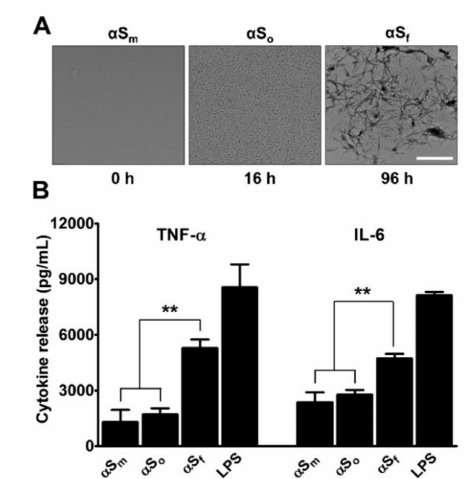
Figure 2. Impact of α -synuclein species on microglial cytokine release. ( A ) Transmission electron microscopy images of α S (70 µ g / ml) samples agitated at 37 ◦ C by orbital shaking and harvested after 16h or 96h. Images show the presence of oligomers ( α S o ) and fibrillary species ( α S f ), at 16 and 96 h, respectively. Scale bar: 1 µ m. ( B ) Impact that samples of α S (70 µ g / mL) harvested after 16 h ( α S o ) or 96 h ( α S f ) of orbital agitation and non-shaken samples ( α S m ) have on the release of tumor necrosis factor (TNF)- α and Interleukin (IL)-6 in microglial cell cultures. Cytokine release was near to zero in control cultures. Lipopolysaccharide (LPS) (10 ng / mL) was utilized as a positive control for stimulation. Data are means ± standard error of the mean (SEM) of three independent experiments performed in triplicate. Note: ** p < 0.01 vs. α S f